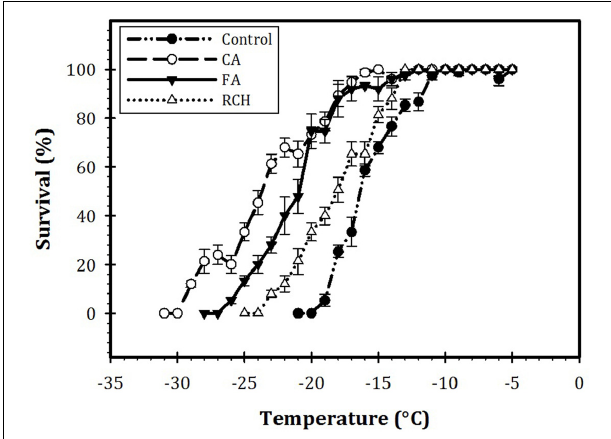
FIGURE 3 | Survival of Trogoderma granarium fourth instar larvae following different thermal regimes after acute low-temperature exposure.